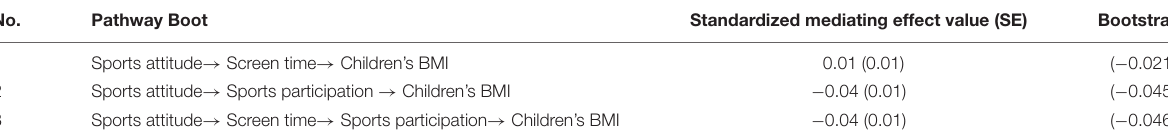
TABLE 5 | A statistical table of path weight coefficient ( N = 589).